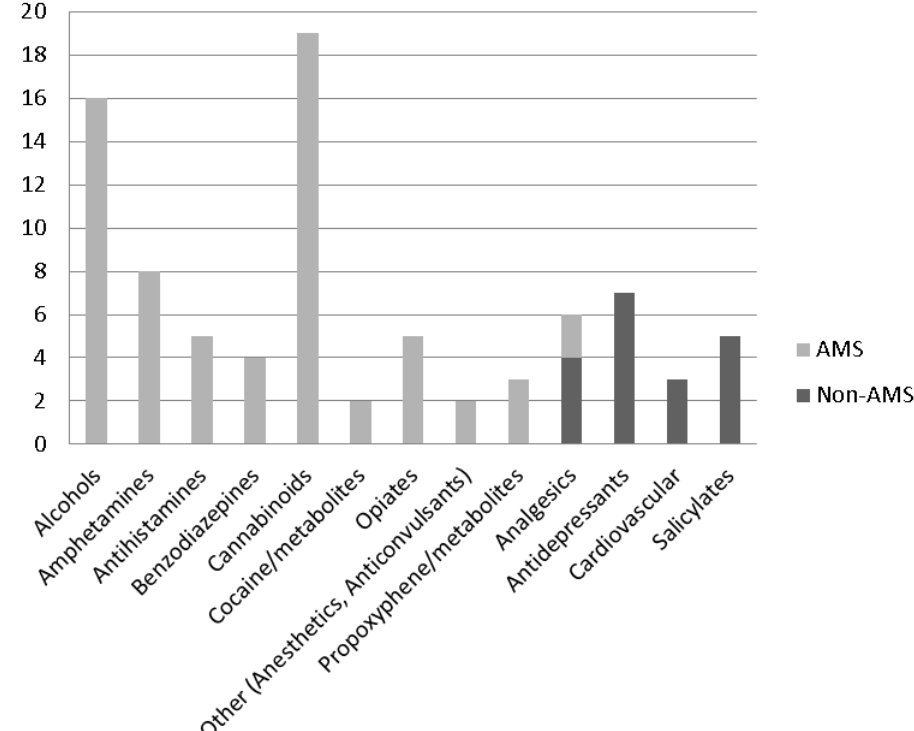
AMS = Alter Mental Status; Other = Anesthetics and anticonvulsants